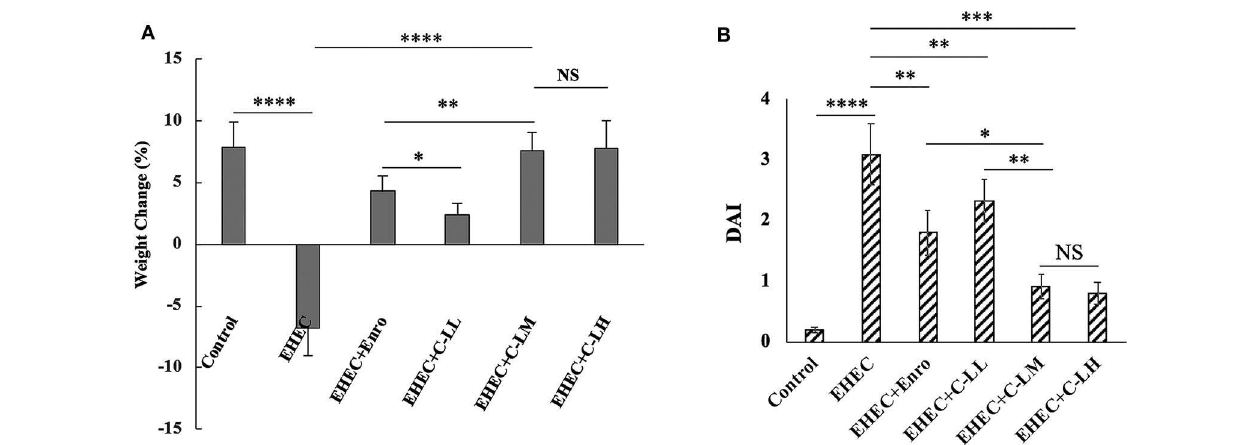
FIGURE 2 | Effect of C-L on the body weight (A) and DAI (B) . The EHEC + C-LL, EHEC + C-LM, EHEC + C-LH, and EHEC + Enro groups were orally administered 100 µ L sterile PBS containing 1 × 10 8 CFUs EHEC O157:H7 and then treated by i.p. injection with 4, 8 mg/kg, or 16mg C-L/kg body weight C-L, or 8mg Enro/kg body weight, respectively, once/day for 3 days. The control and EHEC groups were orally administered 100 µ L sterile PBS or 100 µ L sterile PBS containing 1 × 10 8 CFUs EHEC O157:H7, respectively, without any follow-up treatments. The DAI value was derived from scores relating to weight loss, stool consistency, and occult blood. The data are shown as the mean ± standard deviation ( n = 12). NS, P > 0.05; * P ≤ 0.05; ** P ≤ 0.01; *** P ≤ 0.001; **** P ≤